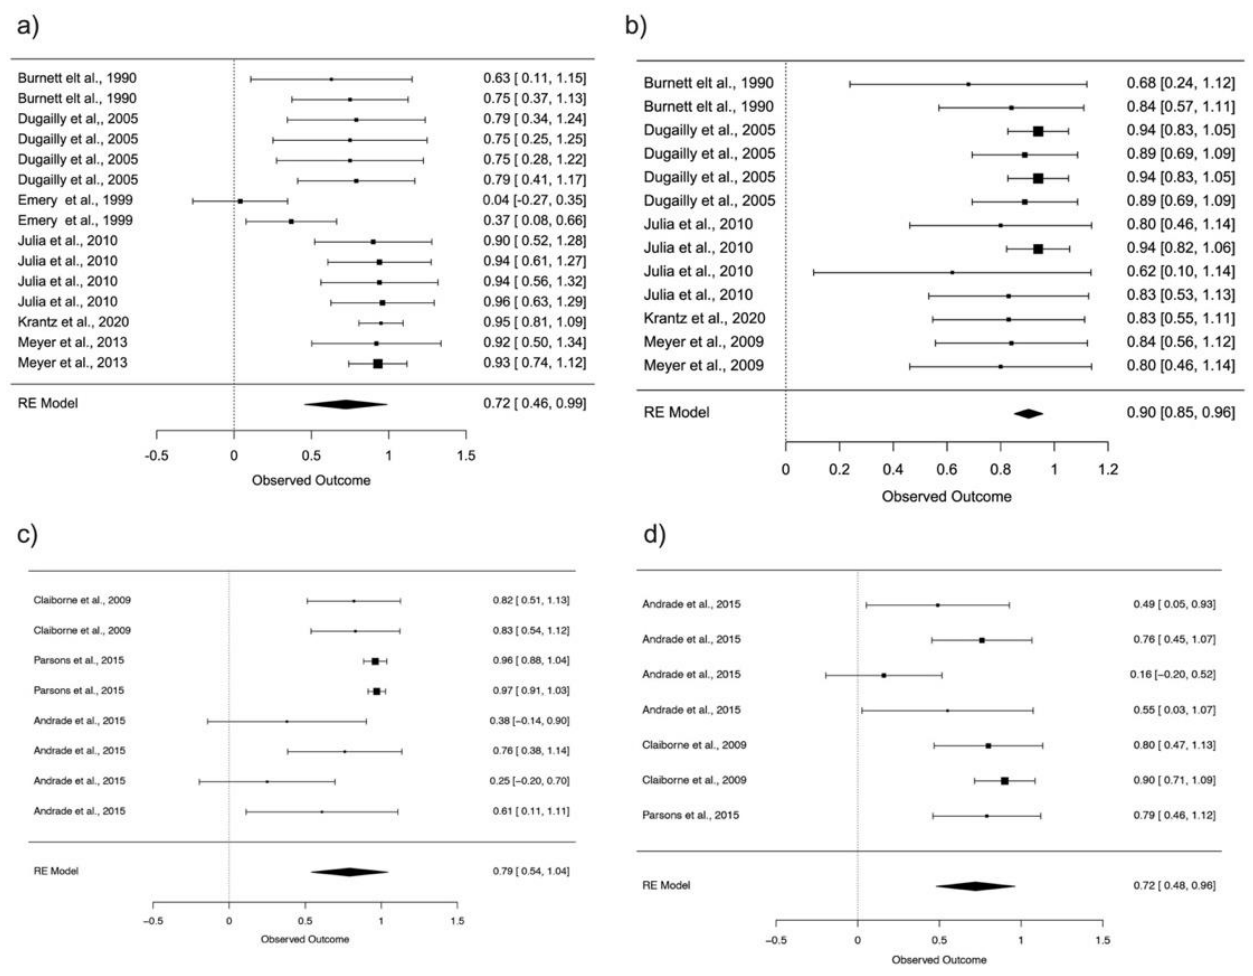
Figure 3. Forest plot, 95% confidence interval (CI95%) for reliability hip flexion in supine position ( a ), reliability hip extension in supine position ( b ), reliability hip flexion in standing position ( c ) and reliability hip extension in standing position ( d ).